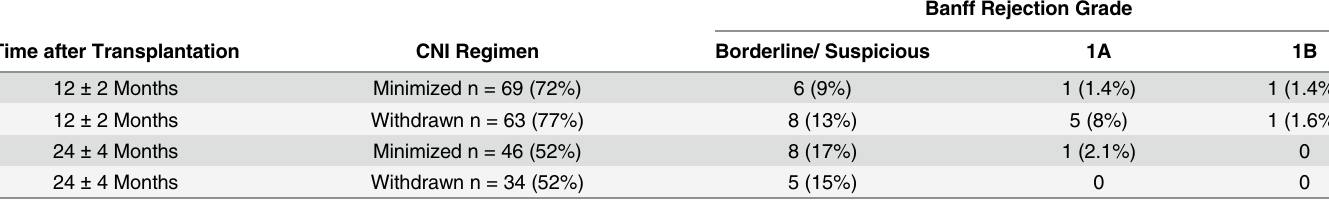
Table 4. Rejection in Protocol